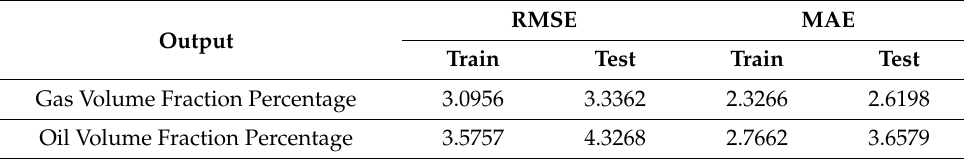
Table 2. Performance criteria of the developed